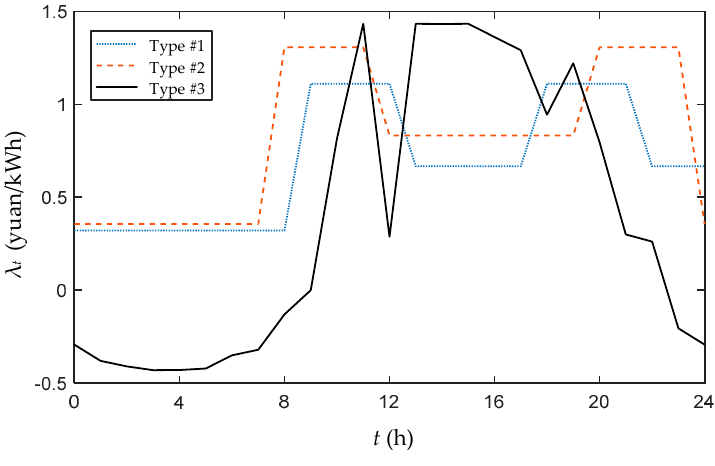
Figure 6. Electricity price of different types (type #1–3). Table 2. Simulation results and verification with different parameter settings.